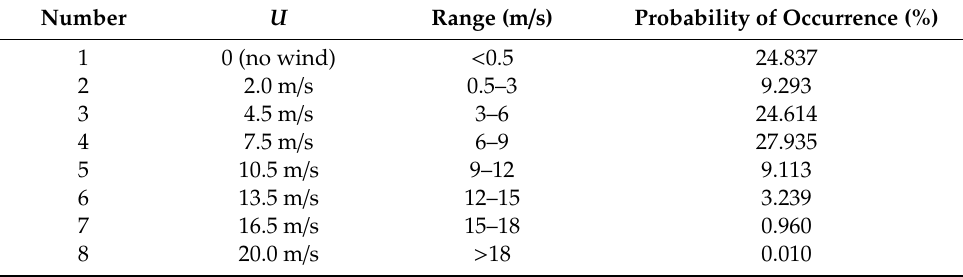
Figure 2. Wind rose diagrams: ( a ) Mean wind velocity (m/s); ( b ) probability of occurrence of wind direction. Table 1. 1 Relative frequency of mean wind speed and direction (%). Table 2. Representative mean cross-wind and probability of